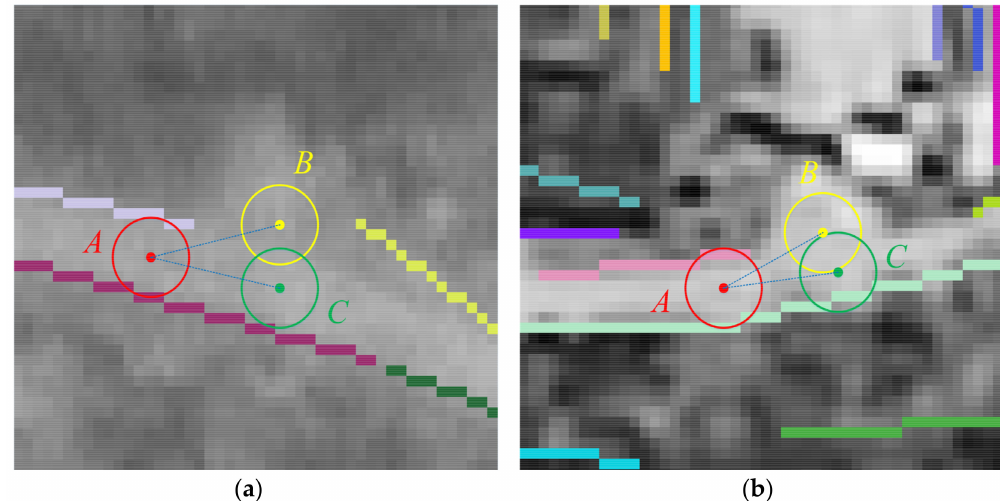
Figure 6. The matching model mainly solves the following two problems: ( a ) The similarity of road and surrounding surface textures. ( b ) The partial occlusion of